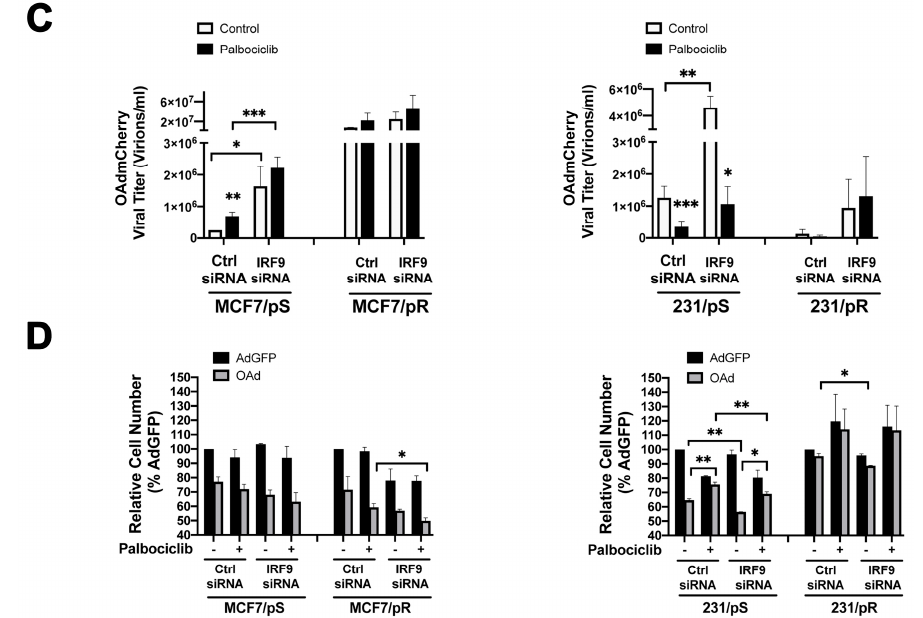
Figure 6. Regulation of viral replication and oncolysis by IFN-regulatory factor 9 (IRF9). Cells were transfected with either control or IRF9-specific siRNA #2 followed by infection with AdGFP or OAdmCherry at a multiplicity of infection (MOI) concentration of five alone or in combination with 500 nM palbociclib for 48 h. ( A ) Type I IFN signaling and expression of E1A viral protein was assessed by immunoblotting with the indicated antibodies. Quantitative densitometry analysis is shown relative to loading control normalized to palbociclib-sensitive control-treated cells (except for MxA in MDA-MB-231 cells and E1A blots where samples were normalized to OAdmCherry Ctrl). ( B ) mCherry expression was evaluated by fluorescence microscopy. Bright field images illustrate cytopathic effect (CPE). Scale: 200 μ m. Images are representative of three independent experiments. ( C ) Cell lysates were harvested and combined with collected supernatants to determine OAdmCherry viral titers. ( D ) Cell number was assessed by crystal violet staining and calculated by measuring the absorbance of solubilized dye at 590 nm. Results are expressed as percent (%) of AdGFP vehicle-treated cells. Error bars, ±SEM of three independent experiments. * p < 0.05; ** p < 0.01; *** p < 0.001; compared to the control unless otherwise indicated.